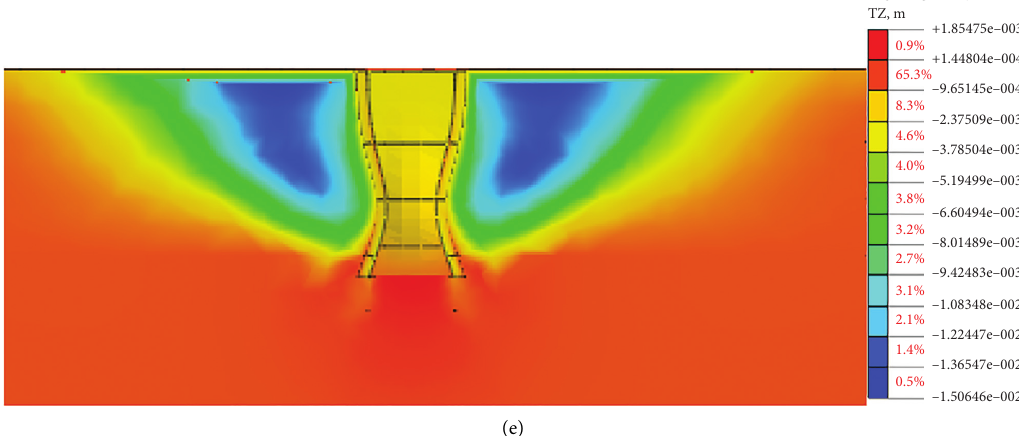
Figure 12: The contour plot of surface settlement and deformation under five excavation conditions. (a) The first excavation step. (b) The third excavation step. (c) The fifth excavation step. (d) The seventh excavation step. (e) The tenth excavation